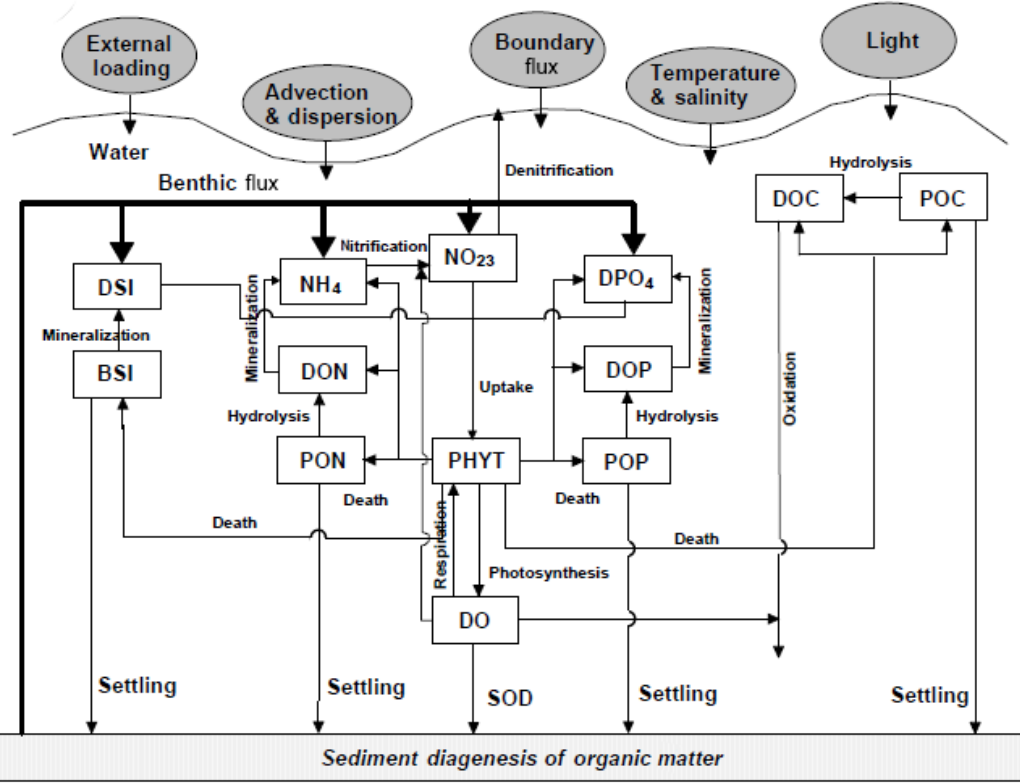
Figure 2. Conceptual framework for the RCA model with a sediment flux module (Zhang and Li, 2010). DO represents dissolved oxygen, PHYT represents phytoplankton, POC represents particulate organic carbon, DOC represents dissolved organic carbon, NH 4 represents ammonia nitrogen, NO 23 represents nitrite and nitrate nitrogen, PON represents particulate organic nitrogen, DON represents dissolved organic nitrogen, DPO 4 represents dissolved inorganic phosphorus, POP represents particulate organic phosphorus, DOP represents dissolved organic phosphorus, DSi represents dissolved silica, BSi represent biogenic silica, and SOD represents sediment oxygen